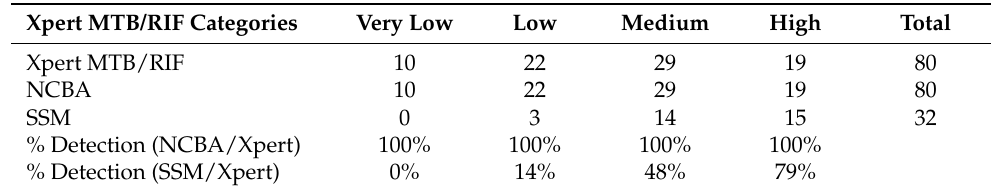
Table 3. Detection limit and dynamic range of detection of the two techniques with respect to the Xpert MTB/RIF categories.